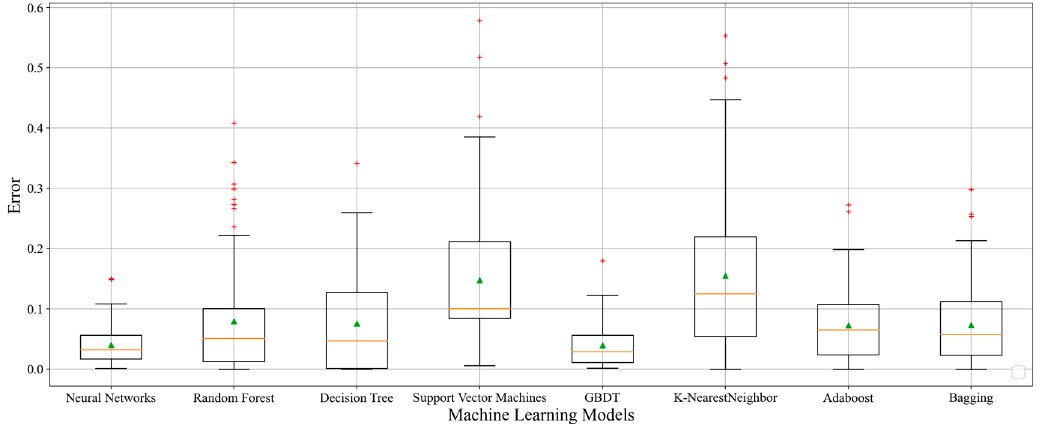
Figure 5. Results of the eight machine learning methods training set.